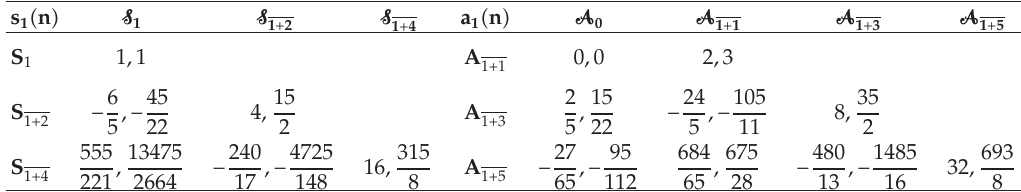
Table 2: Coe ffi cients of the lower order fabric tensors of the second kind using symmetric characterization for vector-valued ODFs (cid:3) 2D and 3D (cid:4) .